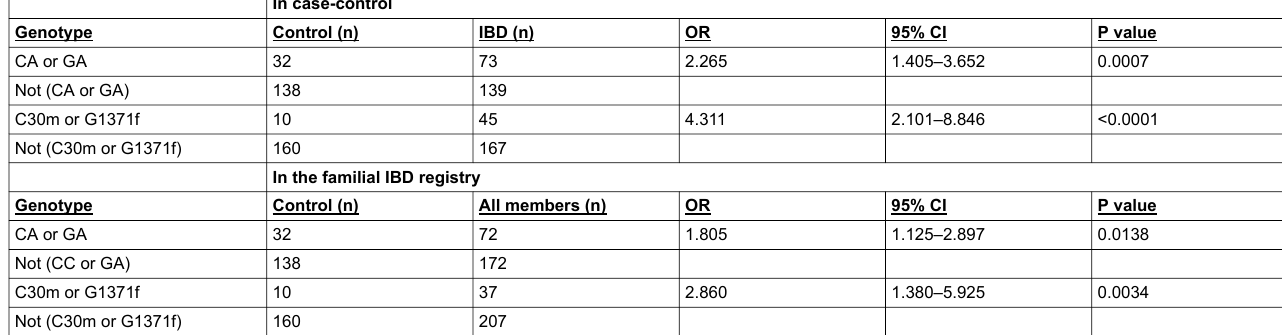
Table 3: Association of A allele of P1371Q and A allele of R30Q with IBD in a familial IBD registry and sporadic